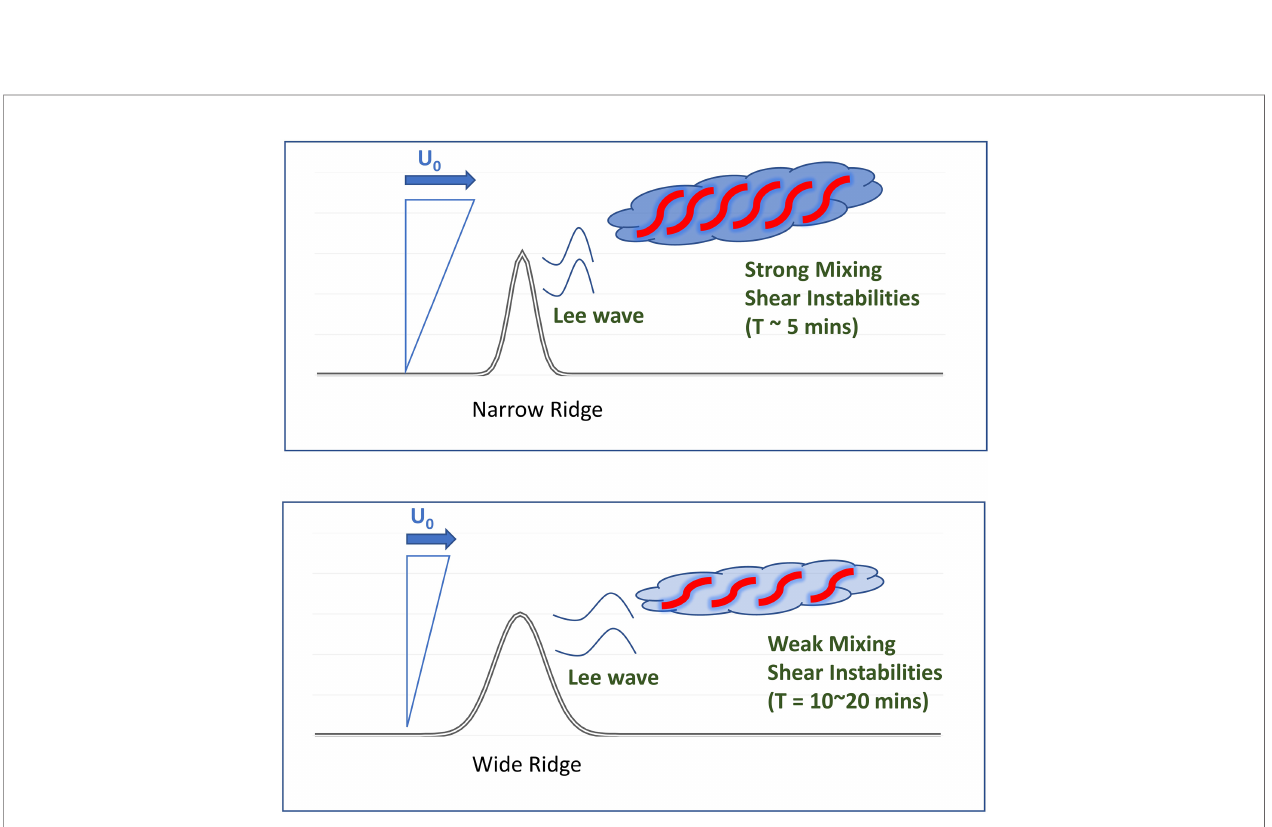
FIGURE 14 | A schematic diagram for the occurrence of mixing intensi fi cation due to fl ow-topography interaction. The typical value of turbulent in the open ocean is O(10 -9 m 2 s -3 ) (Munk and Wunsch, 1998) but the depth-averaged TKE dissipation rate is up to O(10 -5 m 2 s -3 ) due to fl ow-topography interaction. The frequency of mixing enhancement (red braids) and the thickness of mixing layer (blue clouds) are mainly modulated by the fl ow shear and the sea fl oor